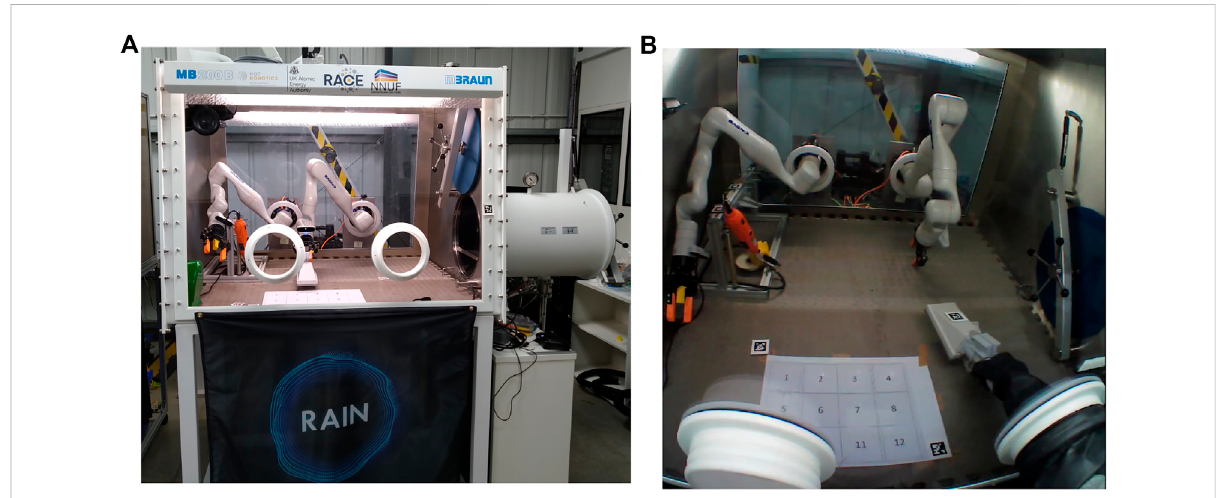
FIGURE 2 (A) Gloveboxusedforexperiments.TheremoteenvironmentismanipulatedusingtheKinovaGen3roboticarmintheright.Thegloveportsare used for accessing the glovebox interior. (B) Glovebox workspace during experimental trials. The grid is placed closer to the operator and robots are turned off during manual manipulation